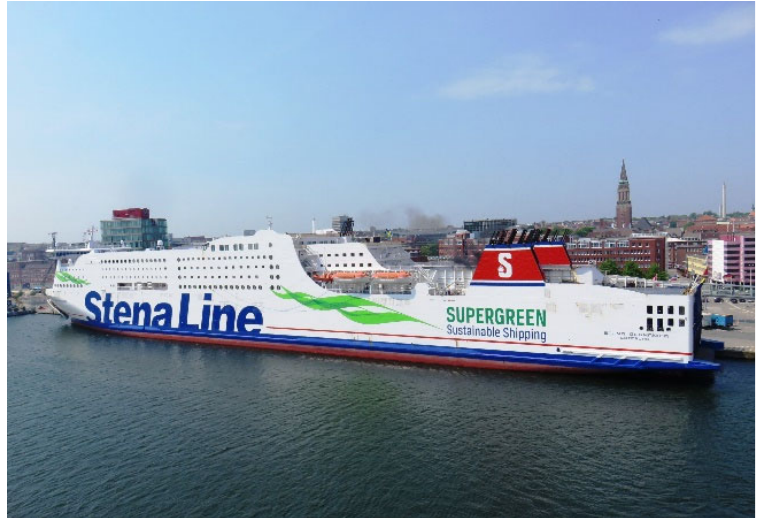
Figure 11. The Stena Germanica, the world’s first methanol ‐ powered ferry, runs in the Baltic Sea [86,87].